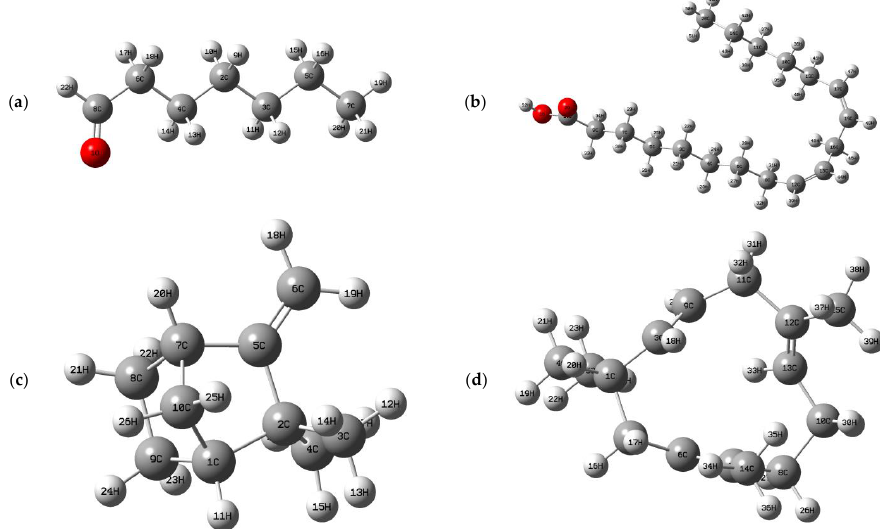
Figure 2. Optimized molecular structures of heptanal ( a ), linoleic acid ( b ), camphene ( c ), and α -humulene ( d ) molecules in essential oil.